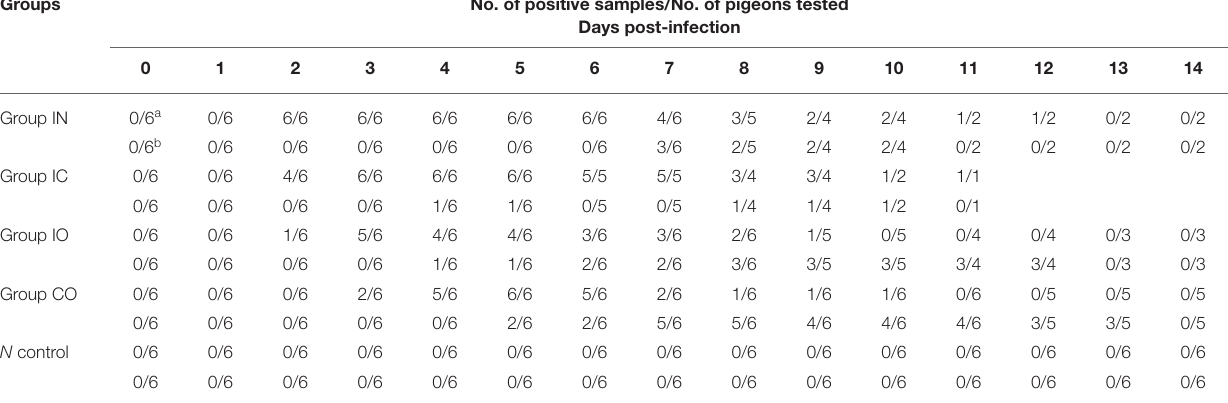
TABLE 2 | Virus shedding of groups. Groups No. of positive samples/No. of pigeons tested